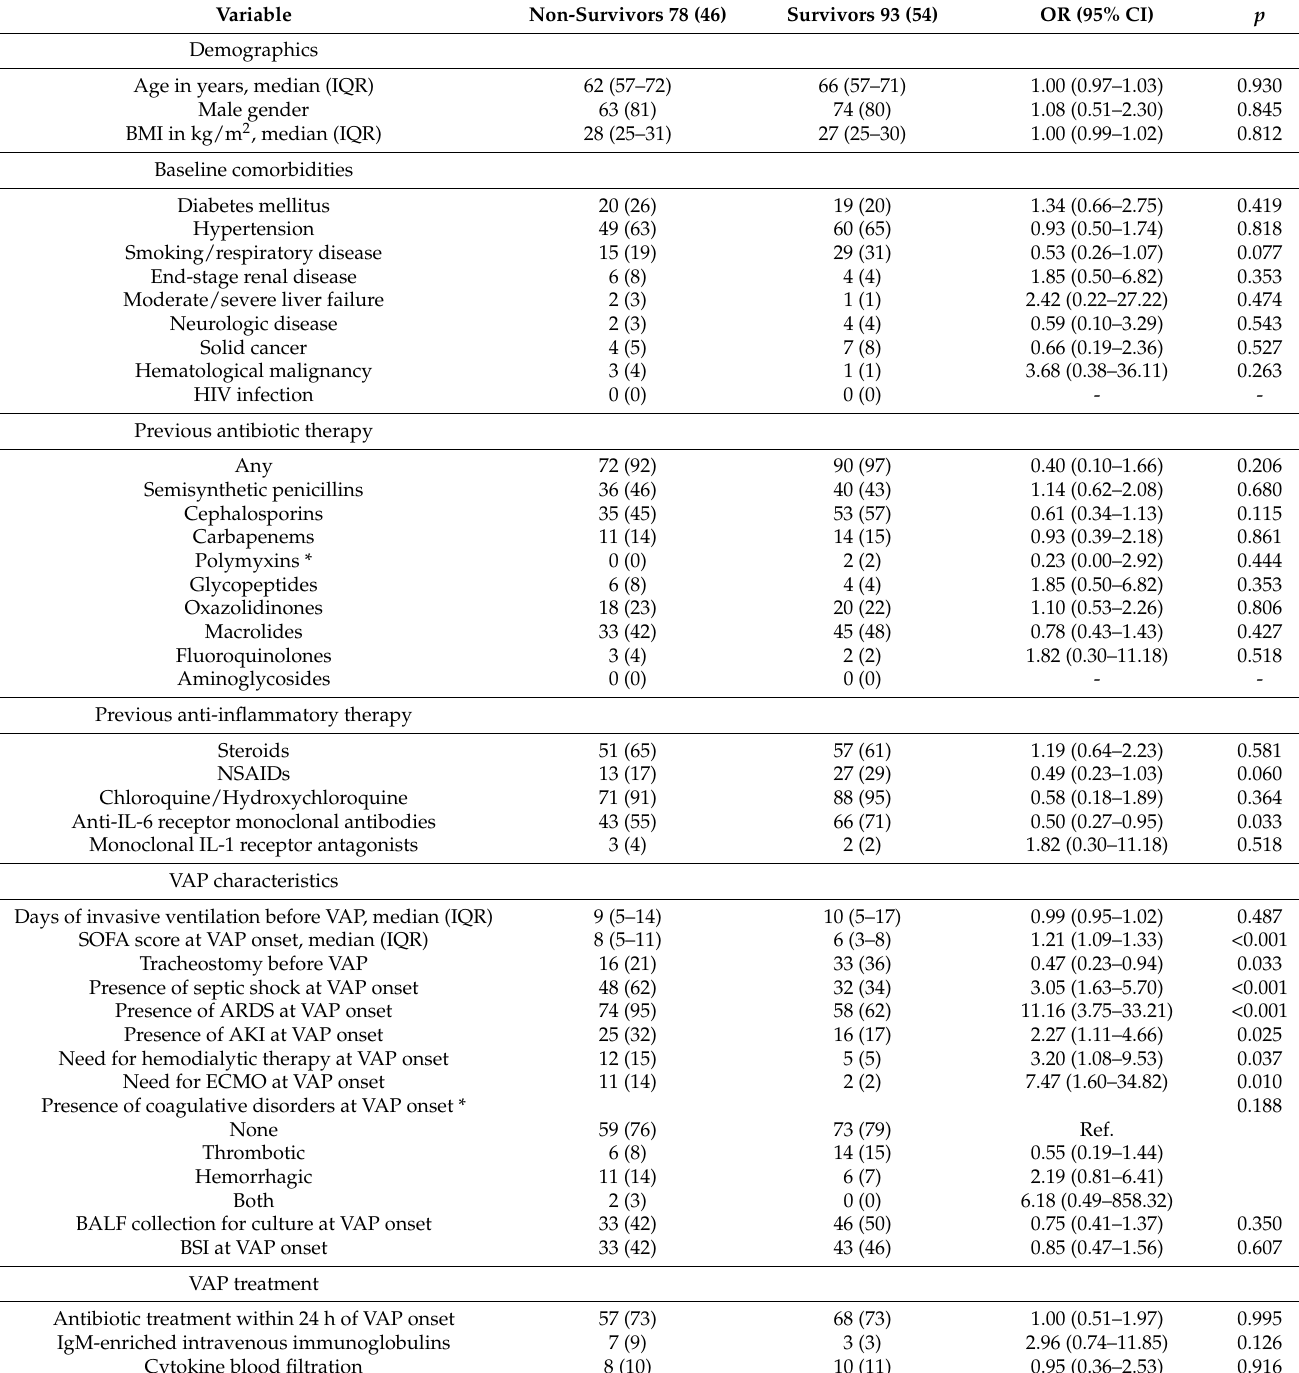
Table 2. Univariable analysis of factors associated with 30-day case fatality in critically ill COVID-19 patients with